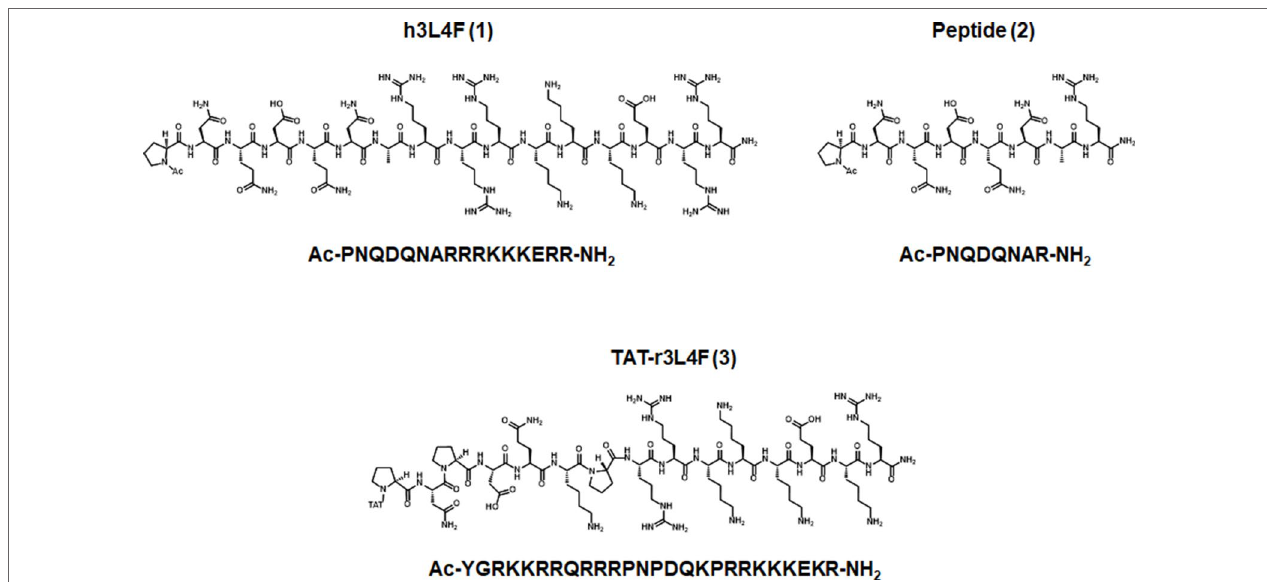
FIGURE 1 | Parent peptides h3L4F (1), 2, and TAT-r3L4F (3), modified from Anastasio et al.,